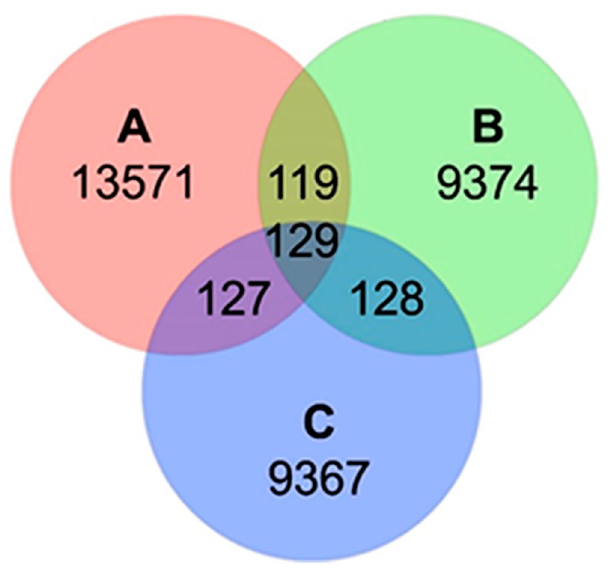
Figure 3. Venn Diagram at a distance of 0.03, illustrating the number of unique and shared subsampled OTUs in the libraries of bacterial communities of the three different cormorant intestine sections (A, B, C). A - esophagus, B - middle, C -